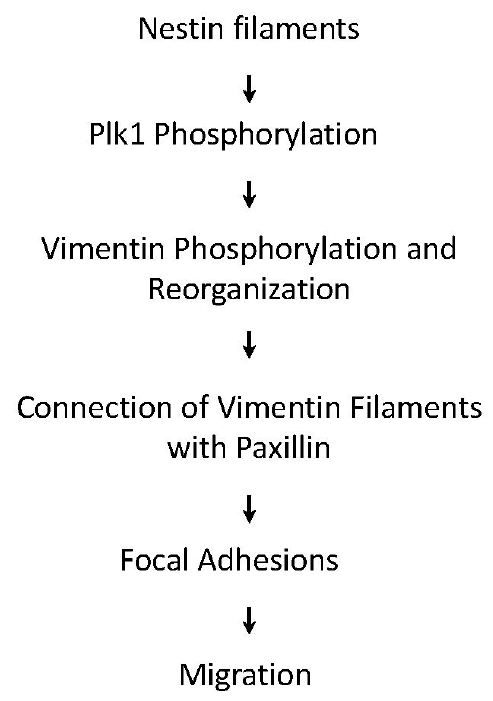
Figure 7. Proposed mechanism: During migration, nestin regulates the activation of Plk1, which mediates the phosphorylation of vimentin at Ser-56. The phosphorylation of vimentin promotes the connection of vimentin filaments with paxillin, focal adhesion assembly, and cell migration.